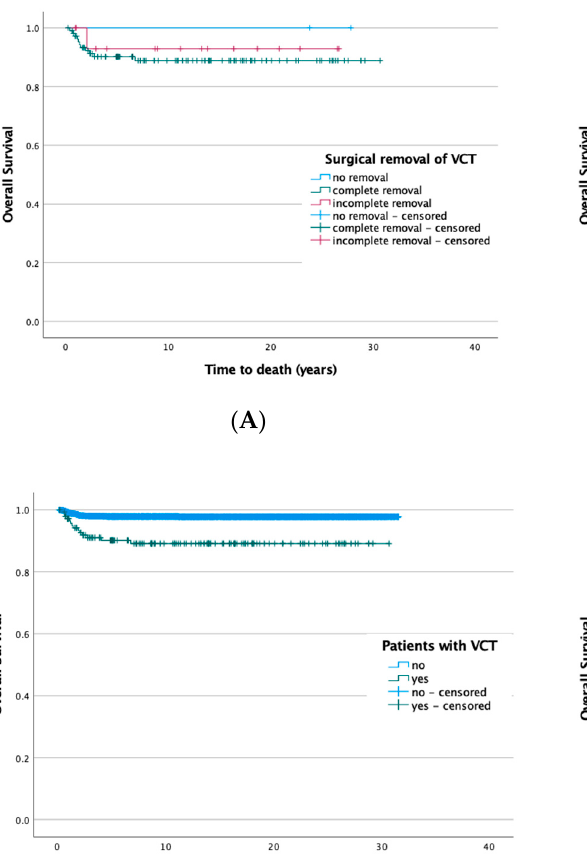
Figure 2. ( A ) OS by surgical approach (complete 89.8%, incomplete 93.8%, or no removal 100%, log rank: p = 0.794). ( B ) Influence of change in thrombus size on OS (yes 92.9%, no 91.6%, log rank: p = 0.749). ( C ) OS of patients with and without VCT (no 97.8%, yes 90.1%, log rank: p < 0.001). ( D ) Overall survival of patients with VCT and anaplasia or no CR after PC and surgery in stage IV (1: n = 35/142) versus the remaining patients with VCT (2: n = 107/142). (OS 1: 77.1%, OS 2: 94.4%, log rank: p = 0.002).